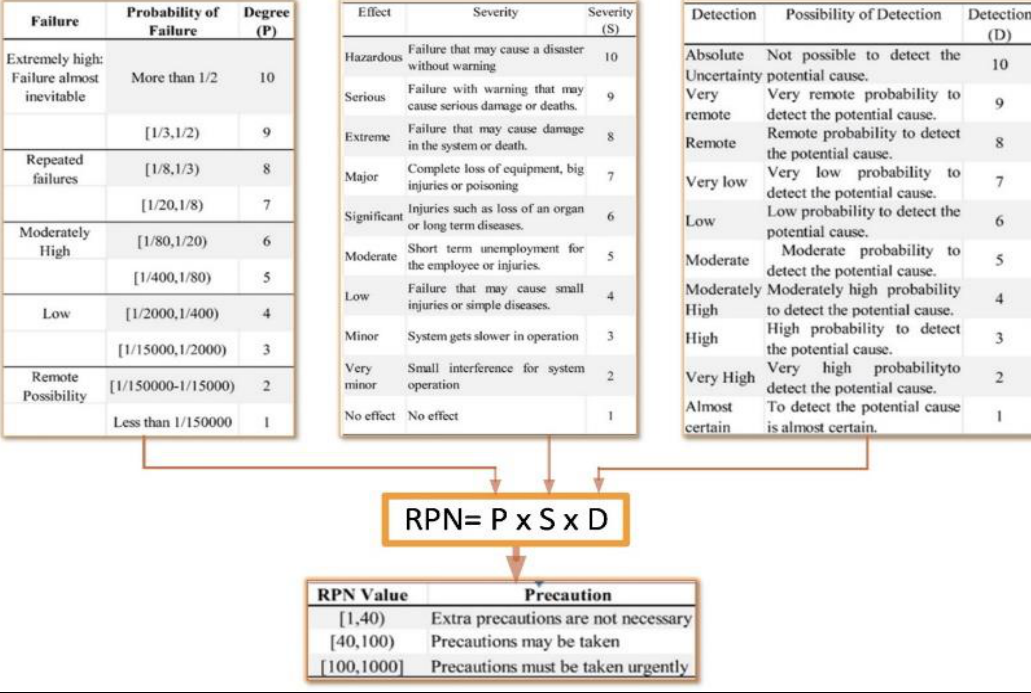
Figure 2: Probability, severity and detectability scales in